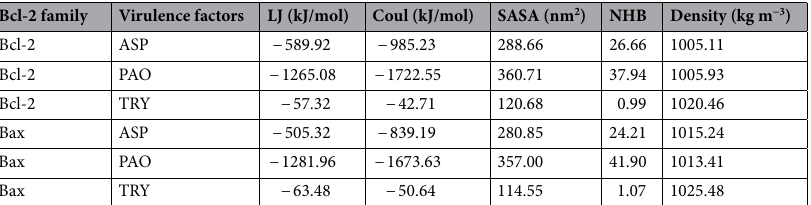
Table 2. Molecular dynamics simulation results. LJ Lennard–Jones interaction, Coul Coulomb interaction, SASA Solvent accessible surface areas, NHB Number of hydrogen bonds (average per